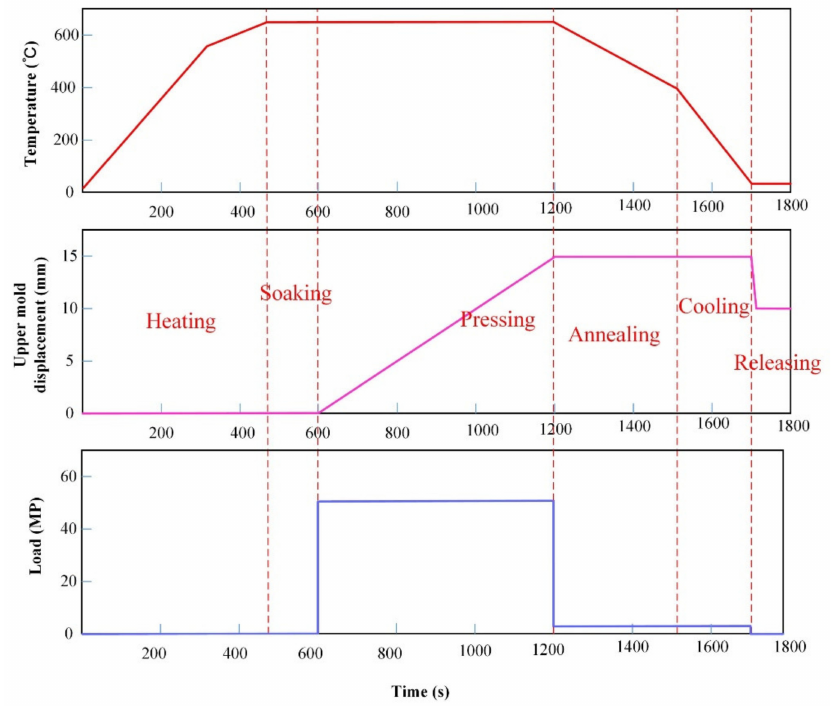
Figure 7. Boundary conditions of three